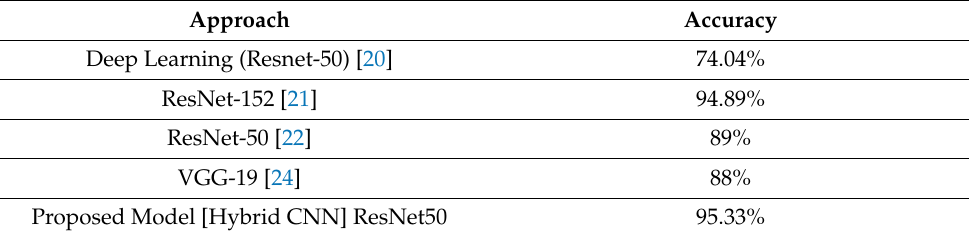
Figure 7. Performance comparison with datasets. Table 15. Comparison Between the Proposed Method with the Existing Studies.